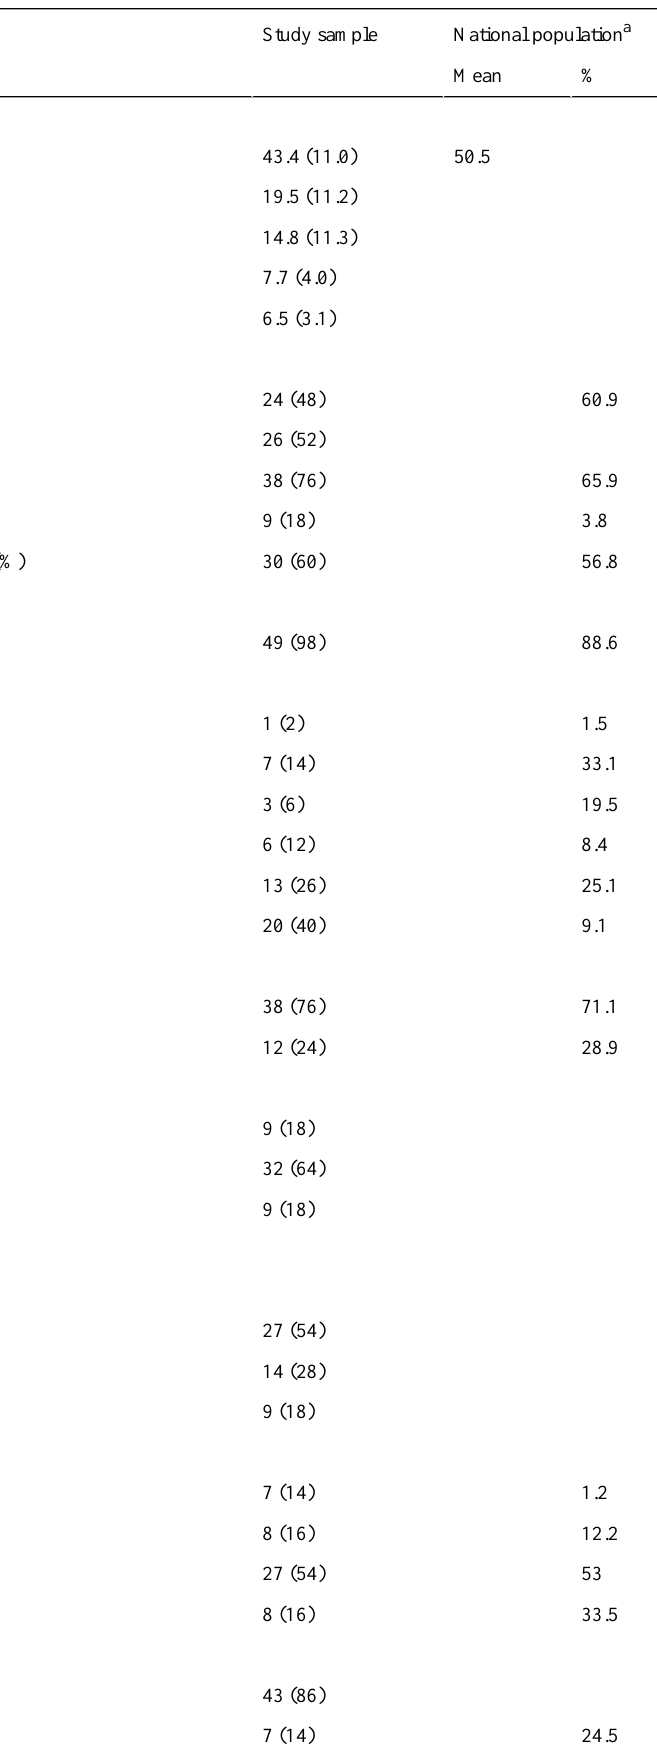
Table 2. Participant demographic information